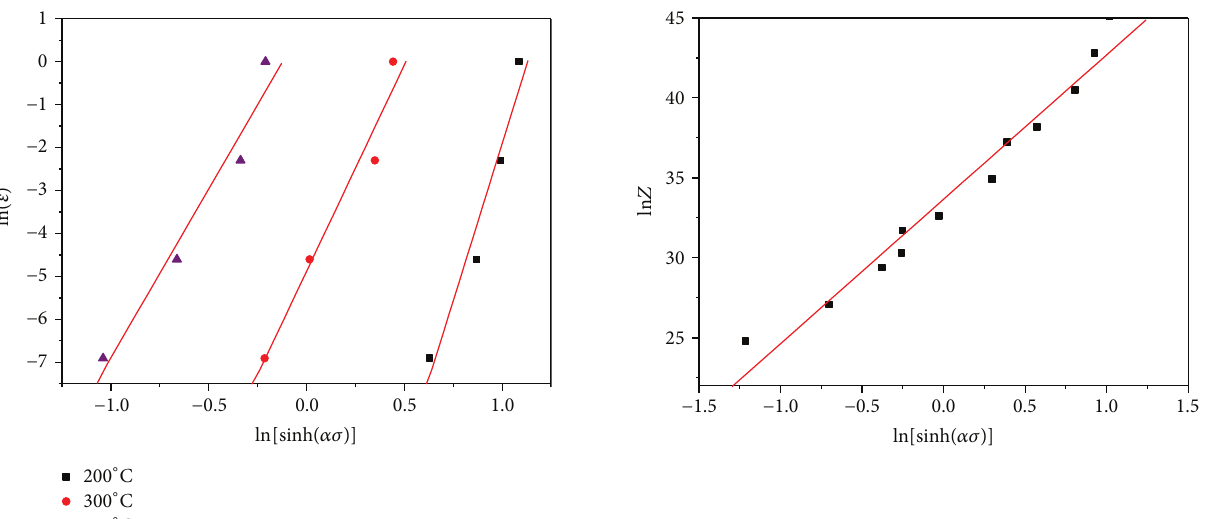
Figure 9: Relationship between parameter 𝑍 and flow stress.